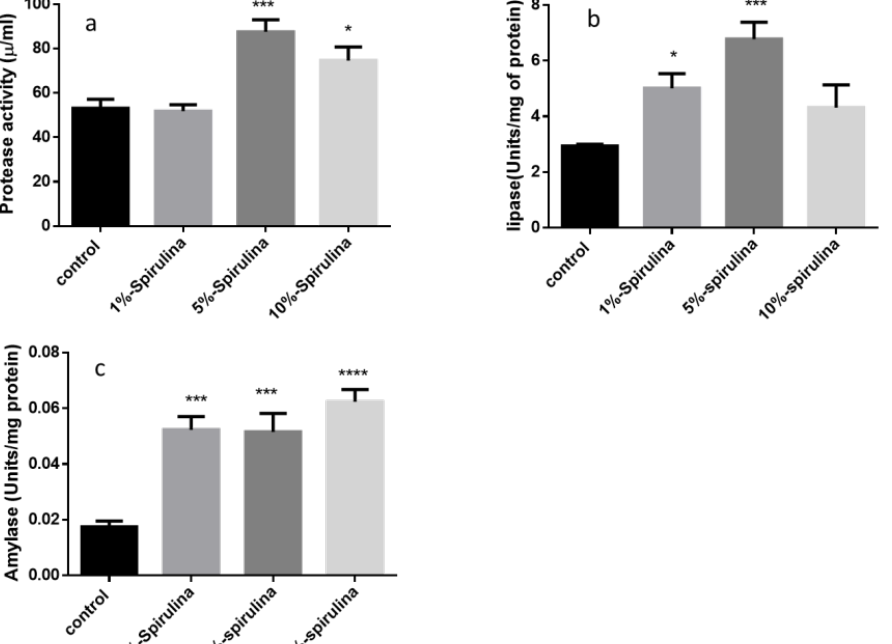
Figure 1. Activity of protease ( a ), lipase ( b ) and amylase ( c ) in the intestine of grass carp fed with various levels of Spirulina supplemented diet for 90 days. Statistical difference p < 0.05 is represented with a single asterisk (*), while triple (***) asterisks represent statistical difference of p < 0.001.